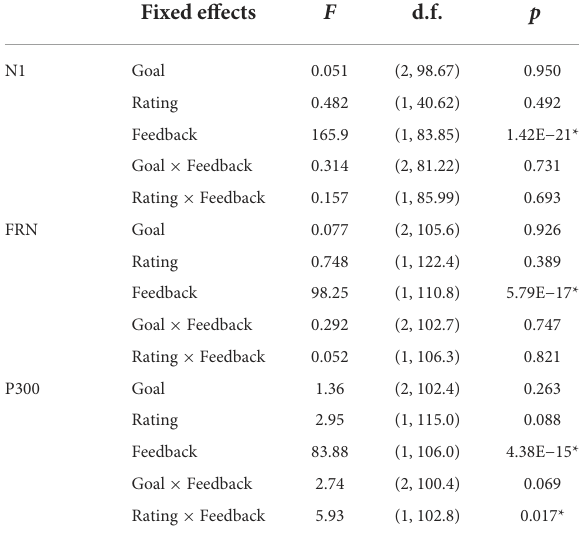
TABLE 3 Summary of statistical analyses ( F -tests) of the mean amplitudes of event-related